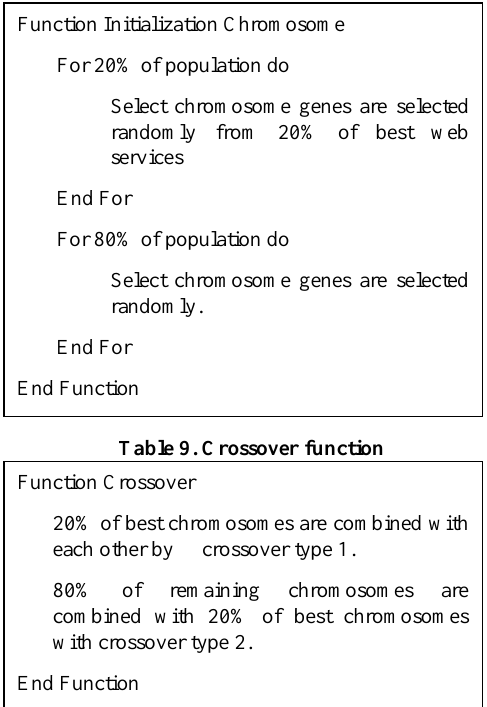
Table 8. Initialization chromosomes function